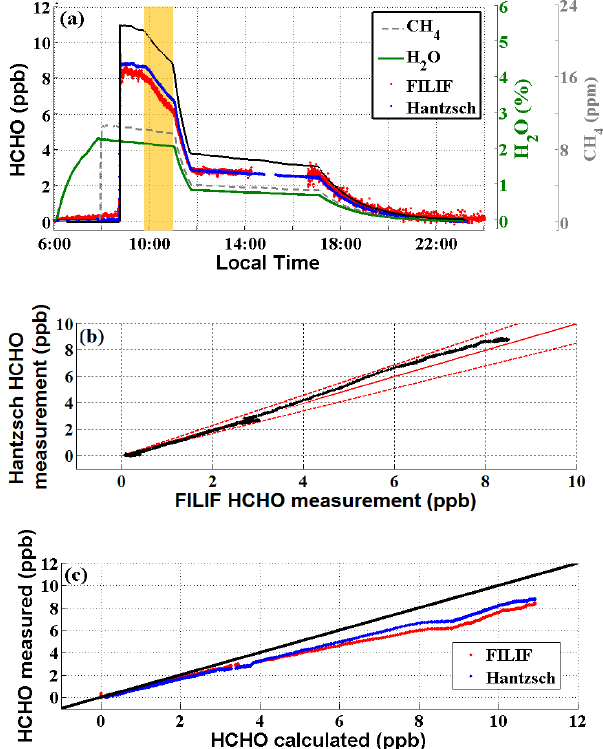
Figure 2. (a) Time series of measured and calculated HCHO mixing ratios, CH 4 , and H 2 O during day 2, with periods of illumination denoted by yellow panels. (b) Comparison between HCHO measurements. Error bars represent 3 sigma precision. Lines represent one-to-one agreement and ± 15% FILIF measurements. (c) Measurement/model comparison, with the line showing 1-1 agreement.